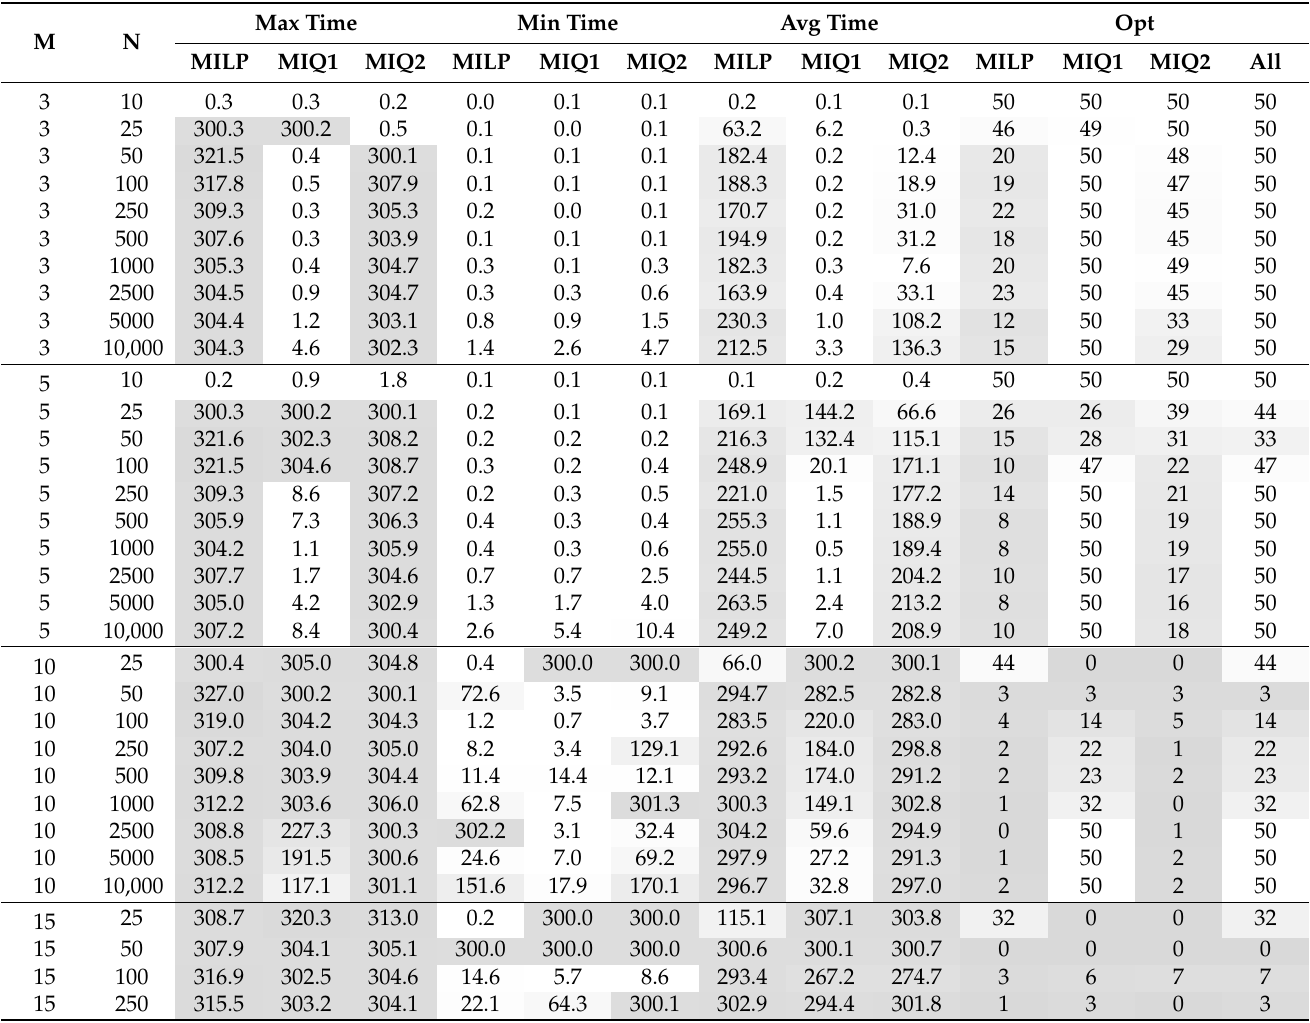
Table 2. Numerical results from DM